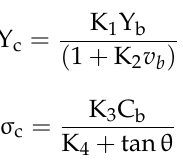
Table A2. Summary of K values obtained from models fit.